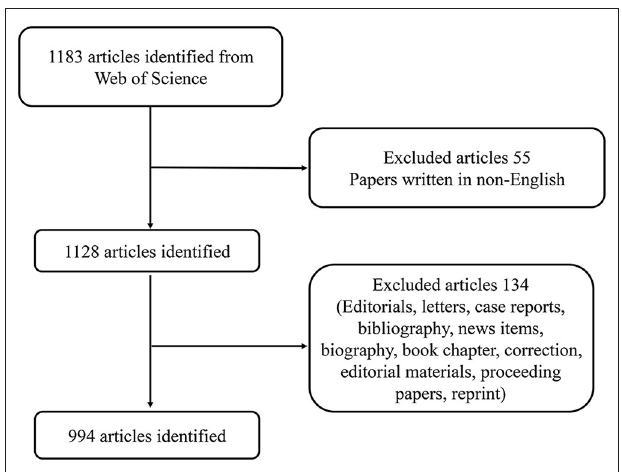
FIGURE 1 | Flow diagram of literature selection and screening in this study.